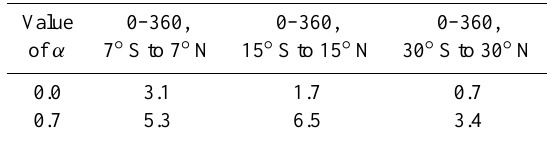
Table 1. Area averaged value of CINE (J/kg) for α =0.0 and α